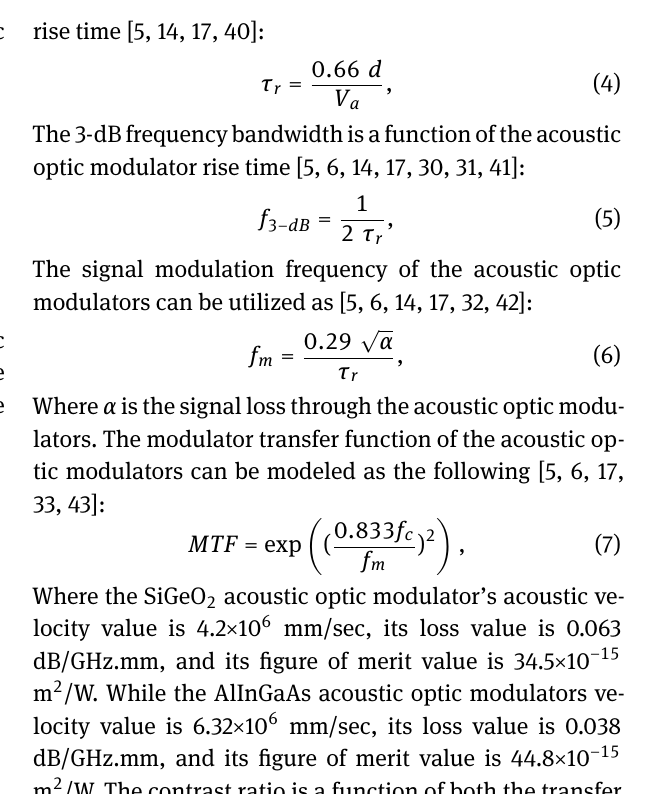
Figure 1: View of the acoustic optic